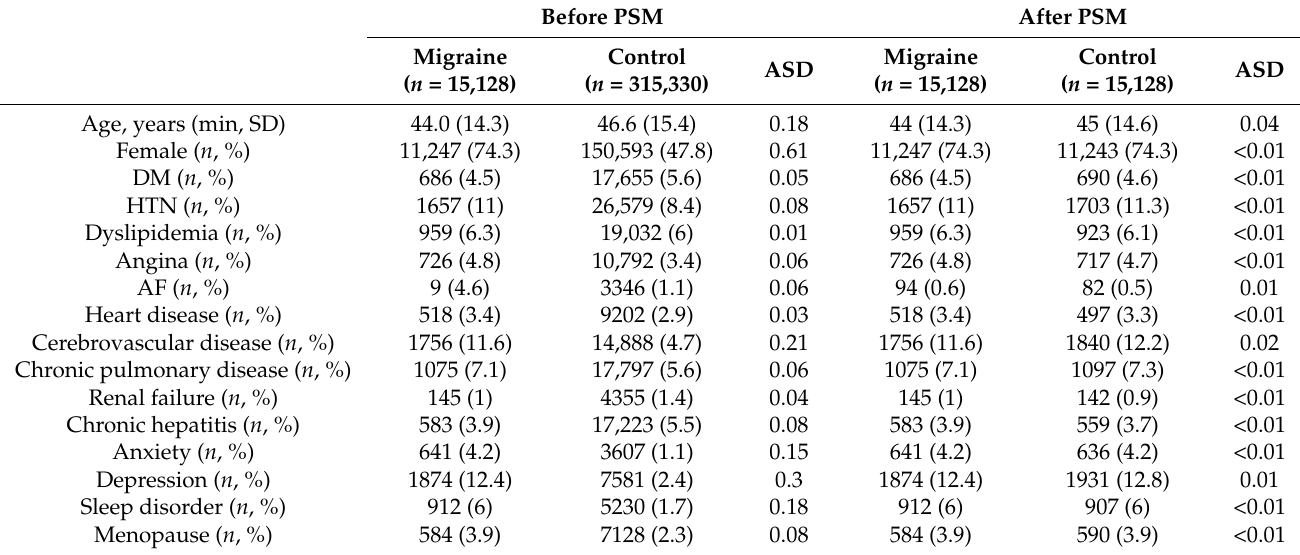
Figure 1. Flow chart of the enrollment process. Table 1. Characteristics of the migraine and control groups before and after